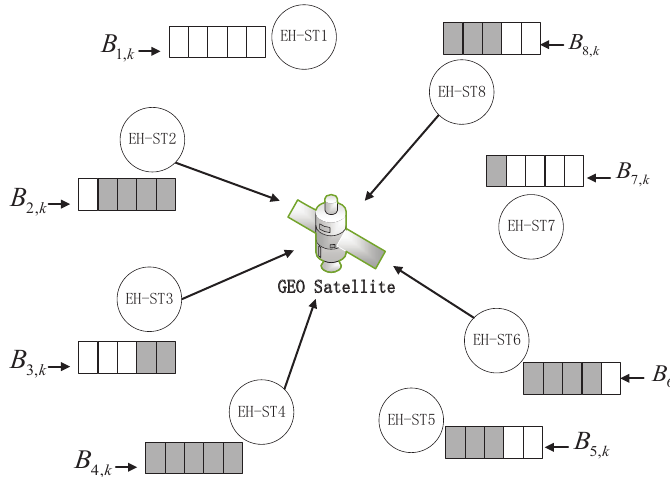
Figure 1. Satellite communication networks with energy harvesting